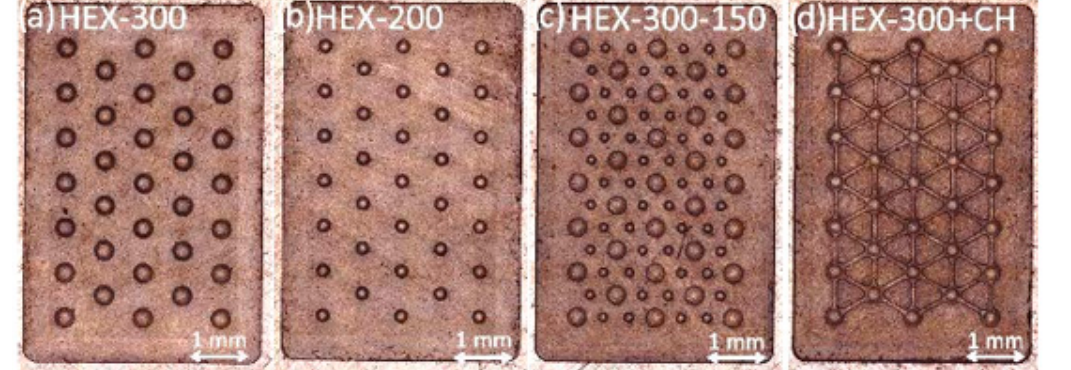
Figure 8. Micro-EDM textured cavities: ( a ) HEX-300; ( b ) HEX-200; ( c ) HEX-300-150; ( d ) HEX-300+CH.